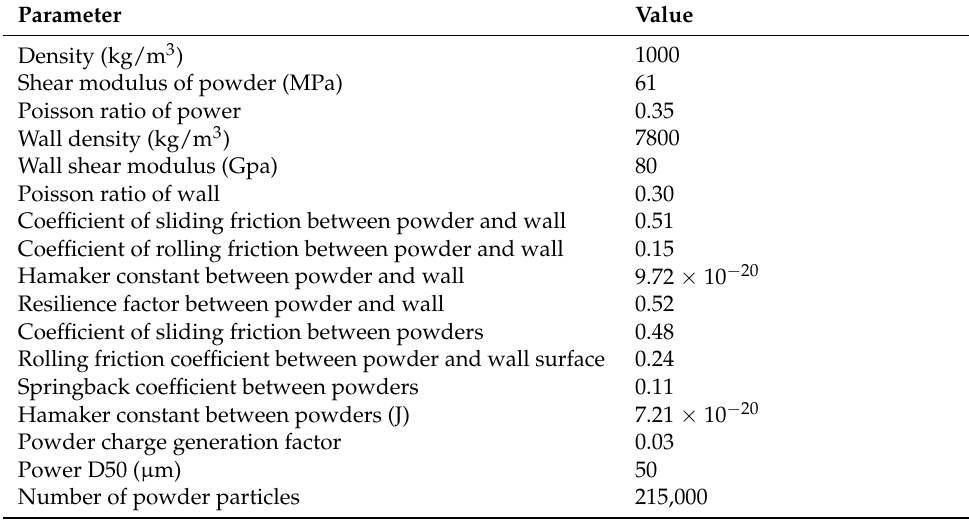
Figure 1. DEM simulation of roller spreading processes. Table 1. DEM model parameters of PA3200 powder spreading process.